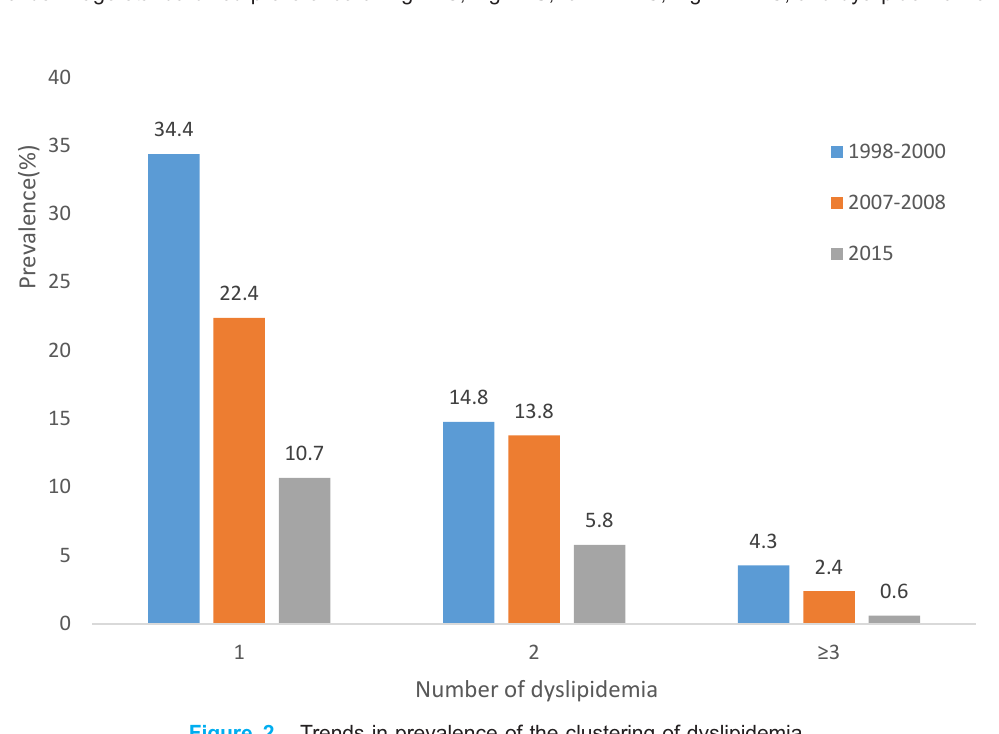
Figure 1. Trends in age-standardized prevalence of high TC, high TG, low LDL-C, high HDL-C, and dyslipidemia from 1998 – 2015